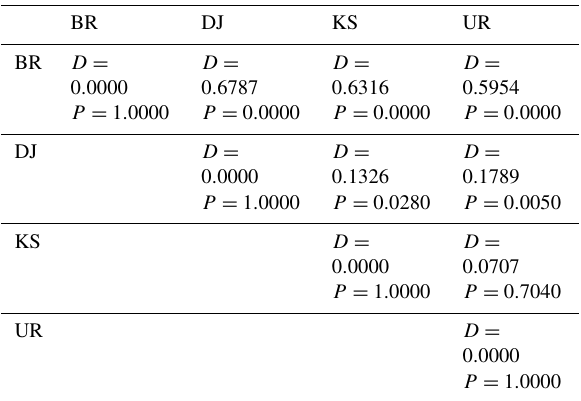
Table 4. Kolmogorov–Smirnov comparison of two data